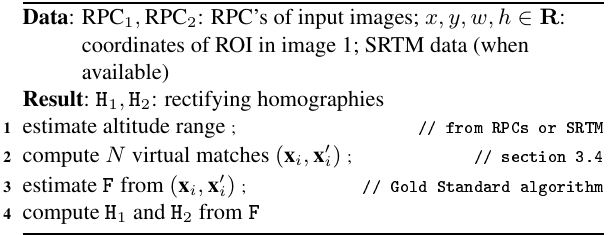
Algorithm 1: Locally affine rectification of pushbroom